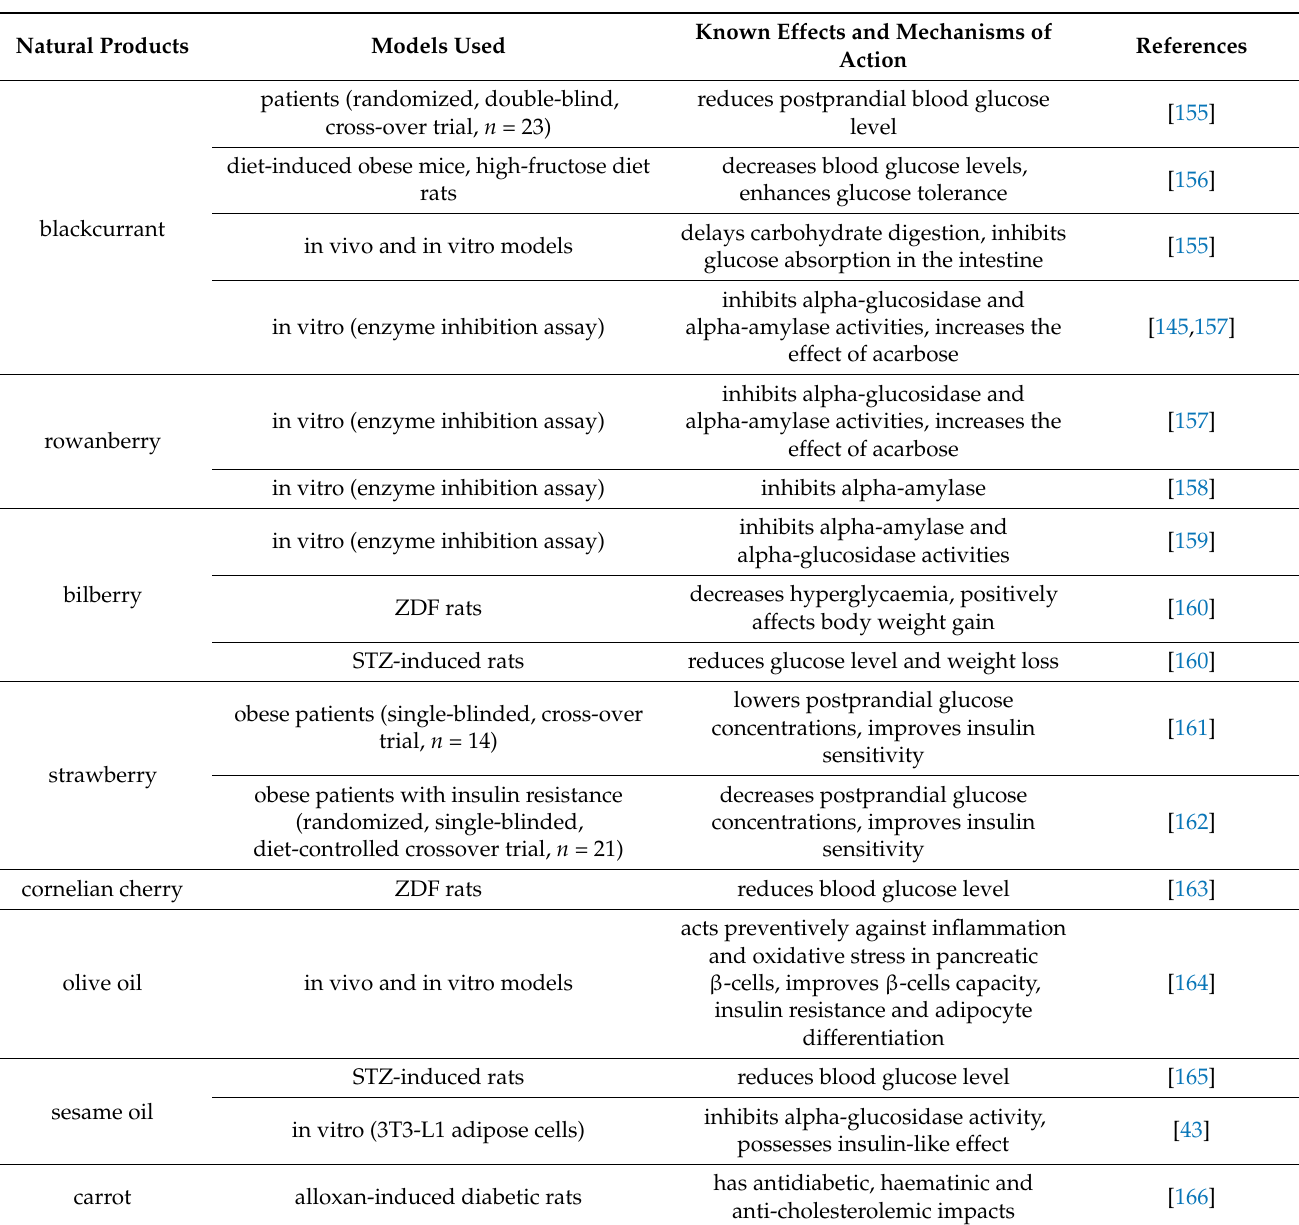
alloxan-induced diabetic